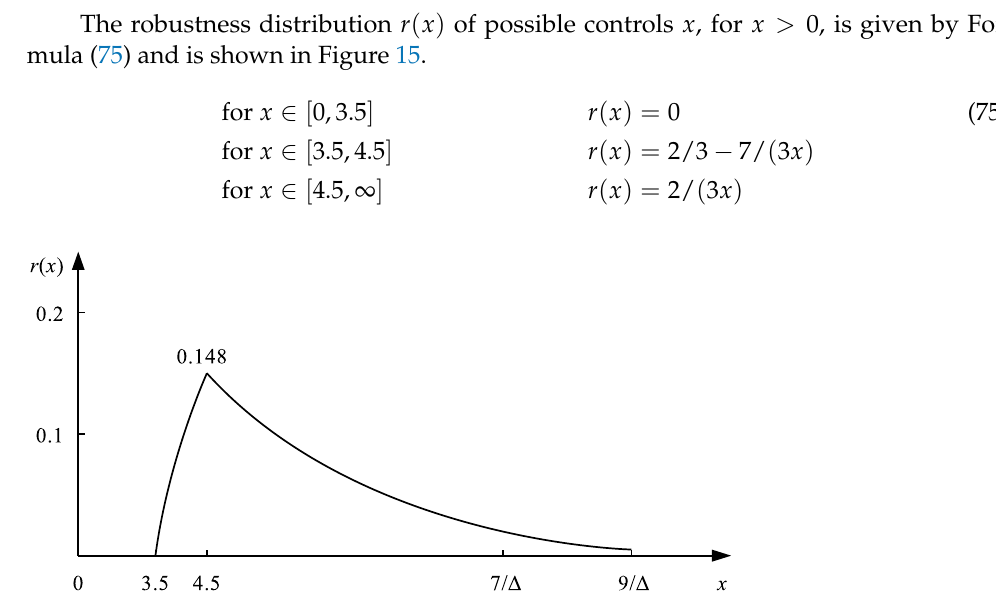
Figure 15. Robustness distribution r ( x ) of the tolerance control x for x > 0.